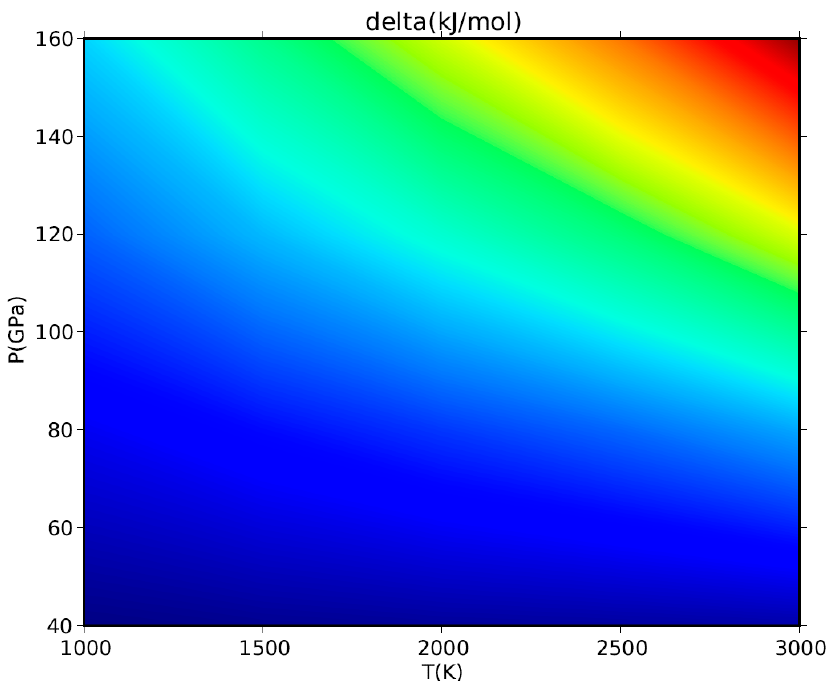
Figure 10. Effect of P–V–T EOS on the volume-pressure integral of MgO. Delta values of Gibbs free energy (in kJ/mol) calculated by using a HT-BM3-EOS or, alternatively, a FPMG-EOS for the volume-pressure integral (see Equation (17)) are plotted between P = 40–160 GPa and T = 1000–3000 K. Color scale as follows: blue = 6–30 kJ/mol; green = 30–45 kJ/mol, yellow = 45–50 kJ/mol, orange = 50–60 kJ/mol, red > 60 kJ/mol.